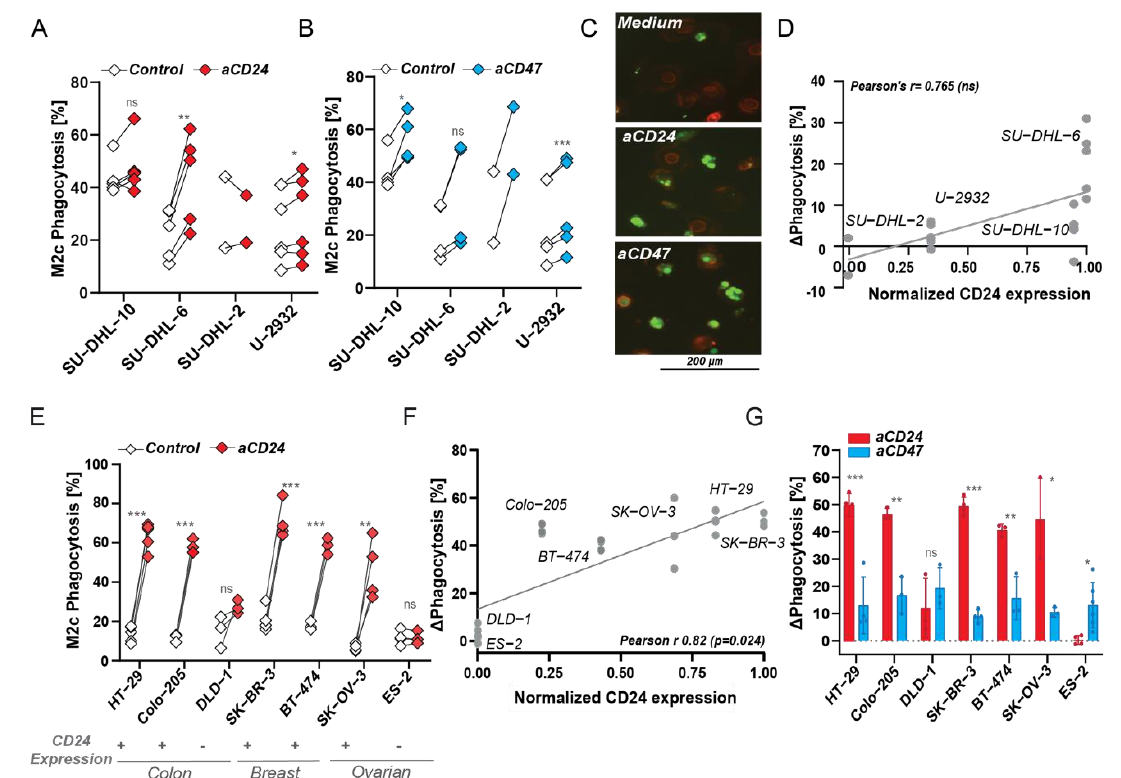
Figure 4. CD24 expression levels positively correlated with CD24 antibody-induced phagocytosis. ( A ) Percentage of phagocytosis upon CD24 SN3 antibody treatment vs. medium control by M2c macrophages (independent donors) in several DLBCL cell lines. Paired t -test. ( B ) Percentage of phagocytosis upon CD47 InhibRx antibody treatment vs. medium control by M2c macrophages (independent donors) in several DLBCL cell lines. Paired t -test. ( C ) Confocal microscopy images of phagocytosis of SU-DHL-6 where macrophages are in red and cancer cells are visible in green. ( D ) Correlation between CD24 expression and increase in phagocytosis upon CD24 SN3 treatment